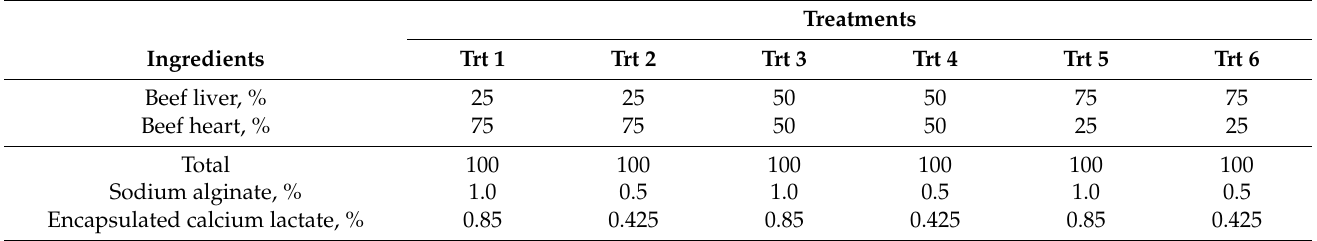
Table 1. Formulations of beef liver (BL) and beef heart (BH) combinations and sodium alginate + en- capsulated calcium lactate (ALGIN) inclusions utilized in the manufacture of pet nutrition